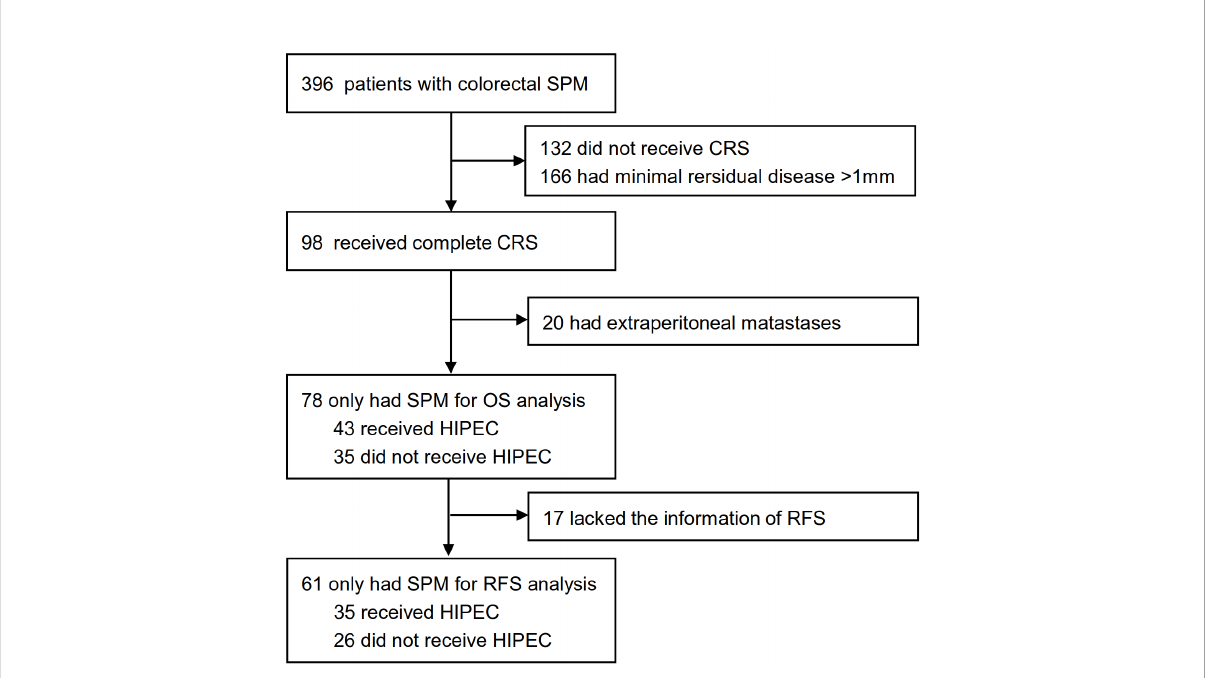
FIGURE 1 Patients selectionand treatment allocation. HIPEC, hyperthermic intraperitoneal chemotherapy; CRS, cytoreductive Surgery; SPM, synchronous peritoneal metastases; OS, overall survival; RFS, relapse-free